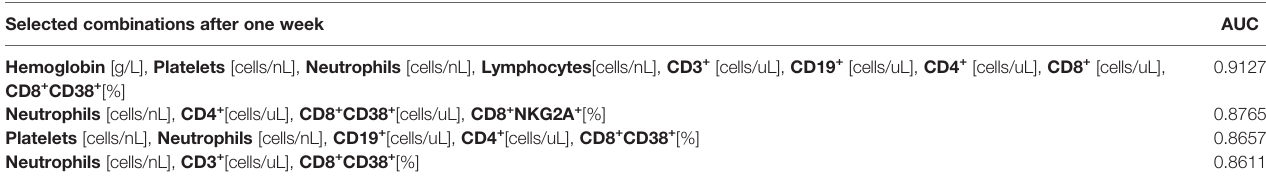
TABLE 6 | Area under the ROC curve (AUC) values for combination of selected variables after one week. Selected combinations after one week